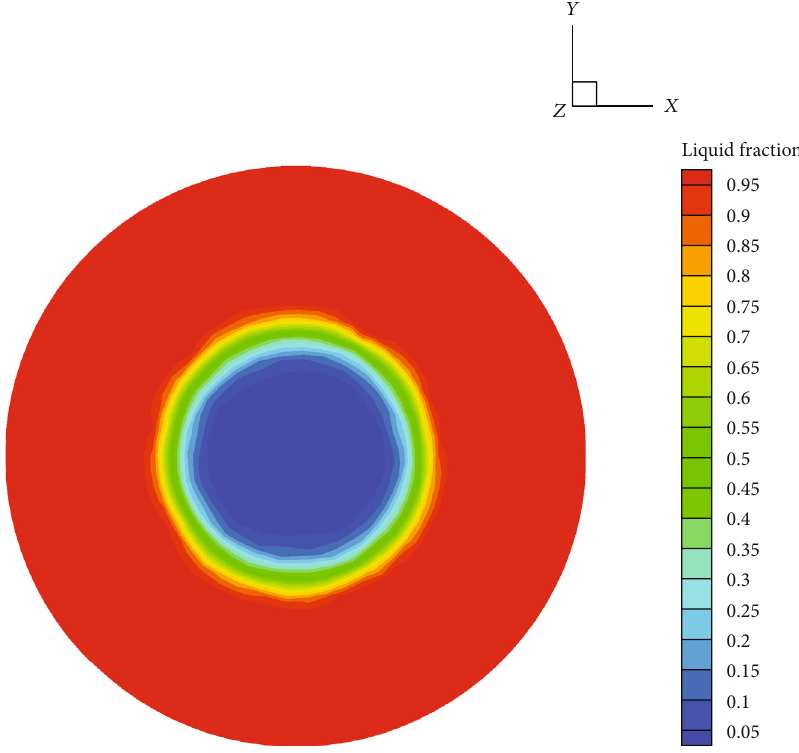
Figure 4: The simulation result for the ice ball by fl uent analysis at 60min. Table 4: The comparison of melting time between fl uent simulation and experimental